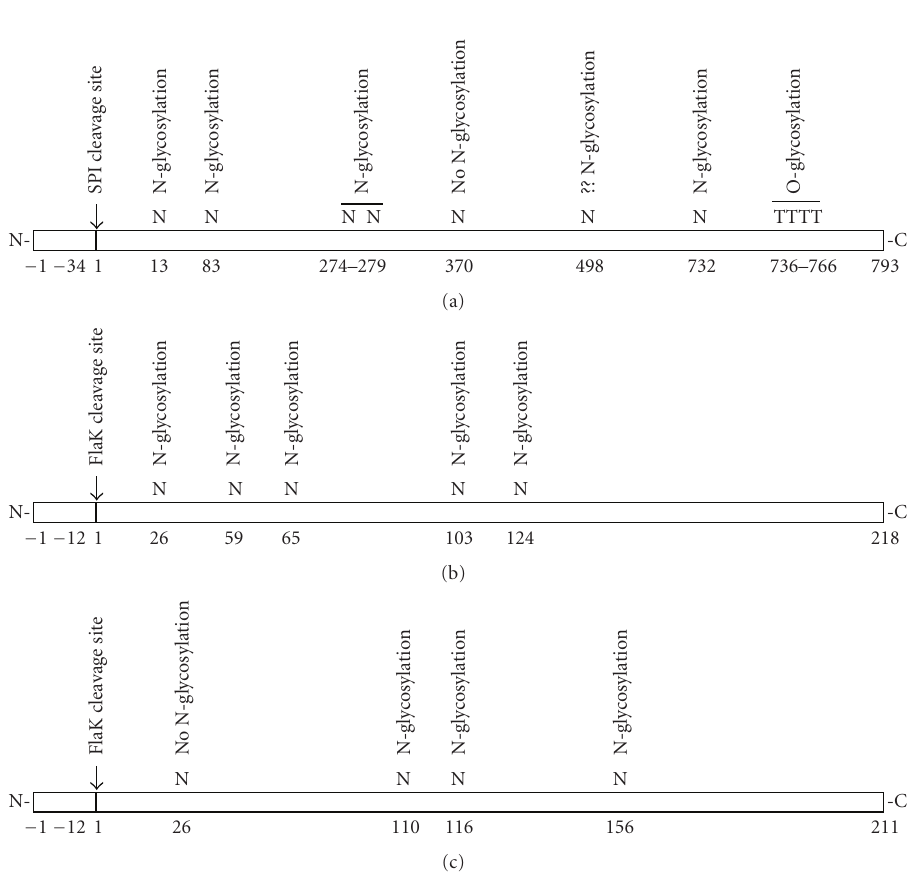
Figure 1: Schematic depiction of the posttranslational modifications experienced by the Hfx. volcanii S-layer glycoprotein and Methanococcus flagellins. A. Hfx. volcanii S-layer glycoprotein; B. M. voltae FlaB1; C. M. maripaludis FlaB1. Below each sequence, depicted by the elongated rectangle, amino acid residue positions are provided. Above each sequence, the residue at that position is listed, as is the posttranslational modification experienced by that residue or region of the protein. For sequon Asn residues, N-glycosylation, no N-glycosylation or unverified (??) N-glycosylation is marked. Note that the three sequences are not drawn to